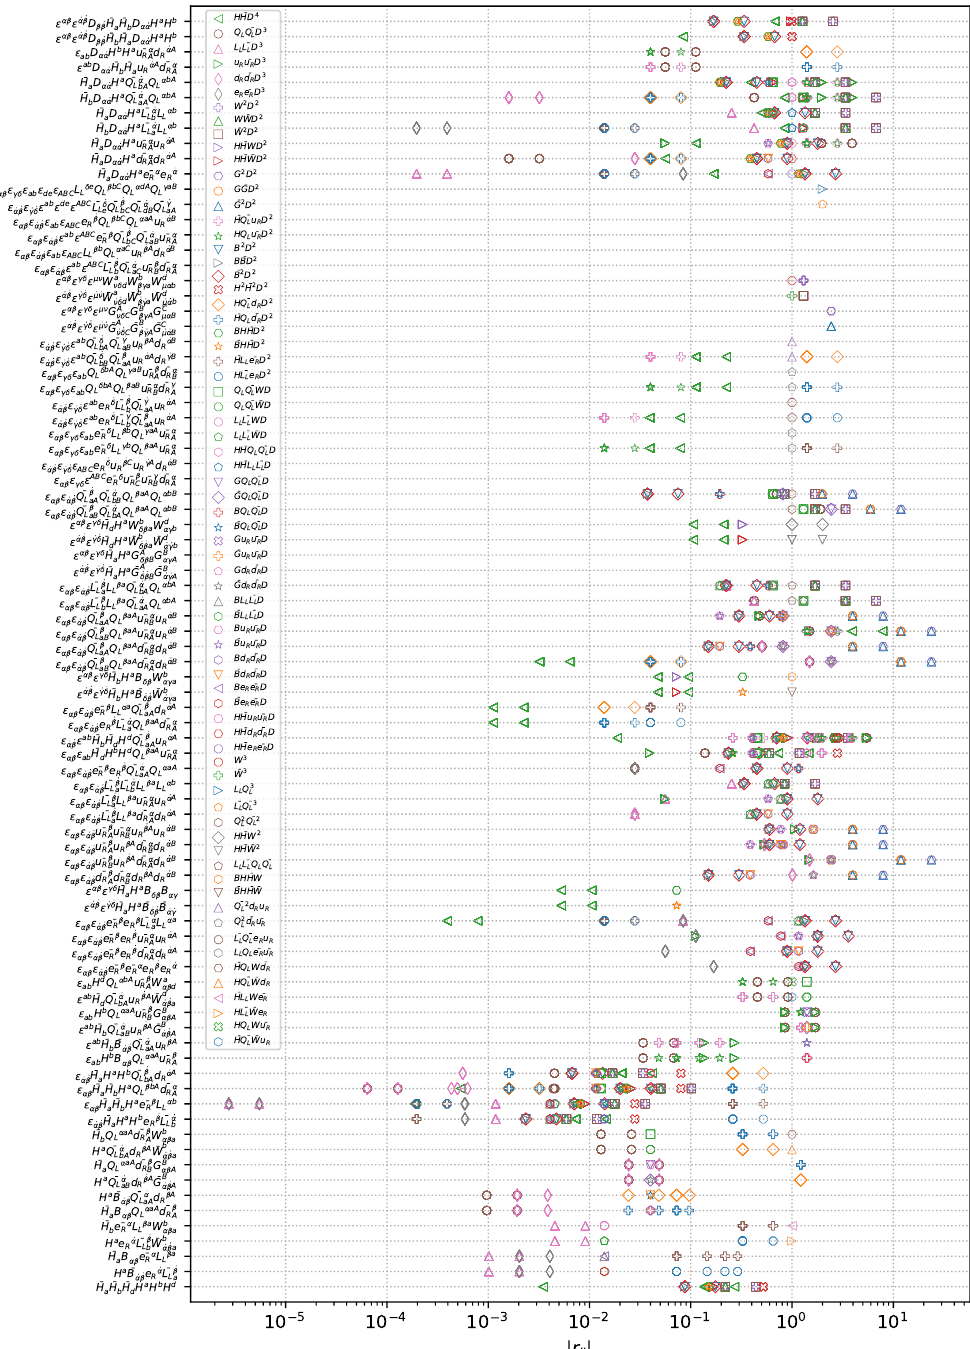
Figure 2 . The absolute values of the non-trivial components of R ij , de(cid:12)ned in (2.15), for the one generation SM. Each marker is positioned in line with the basis operator corresponding to index j , and formatted according to the (cid:12)eld composition of the redundant operator corresponding to index i . We de(cid:12)ne the marginal couplings in terms of the measured coe(cid:14)cients of the three generation Stan- dard Model: the Higgs quartic and gauge couplings equal those measured at the Z pole, whereas the Yukawa couplings are set by measurements of the heaviest generation: y u = m t